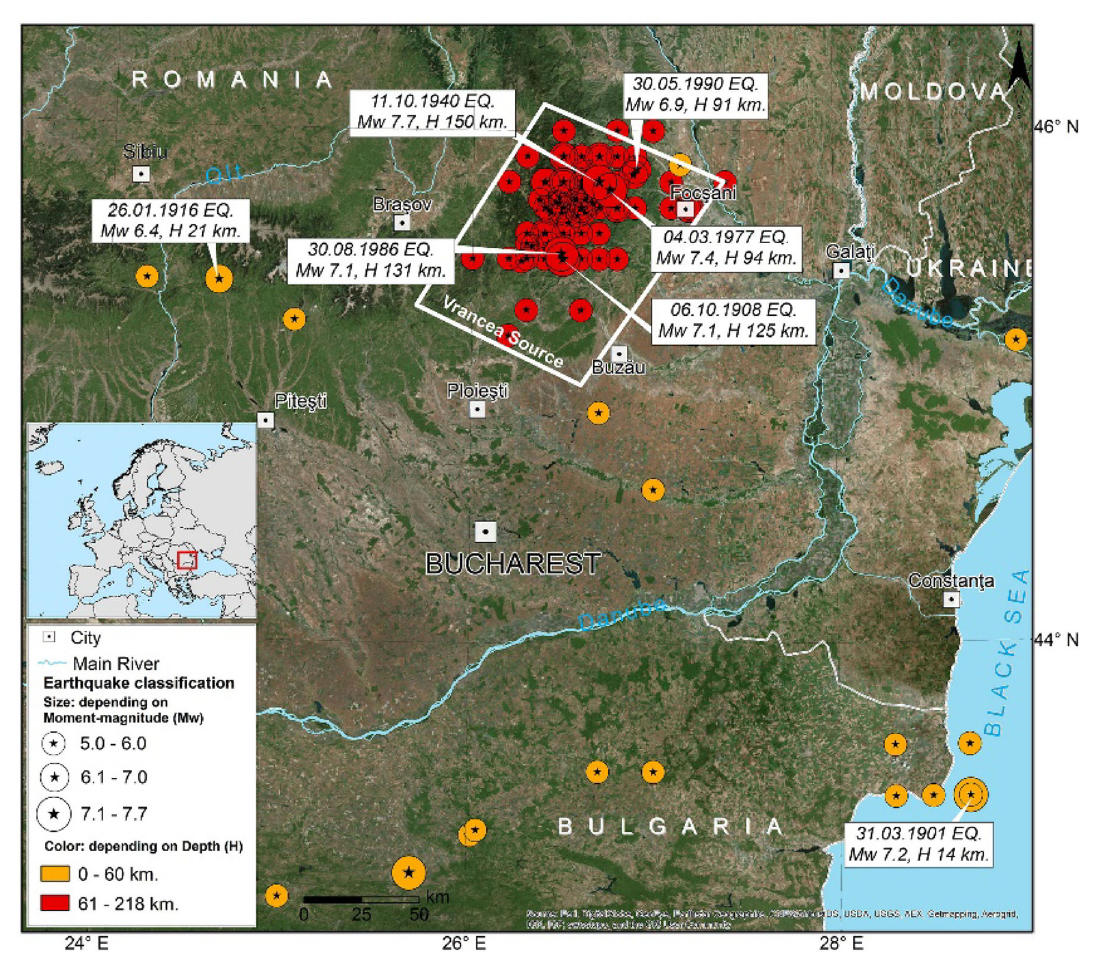
Fig. 1 Earthquakes near Bucharest with moment-magnitude C 5 between 1900 and 2016. Data source NIEP